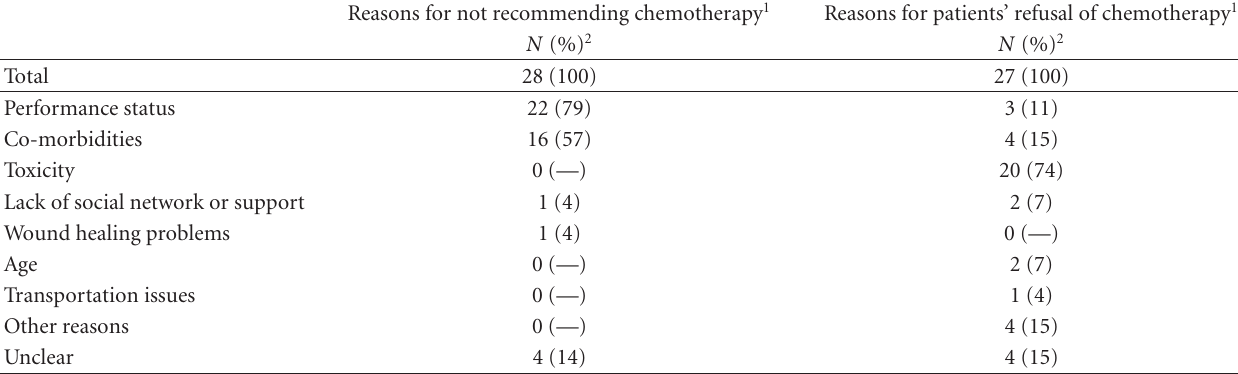
Table 3: Oncologists’ reasons for not recommending chemotherapy and patients’ reasons for refusing